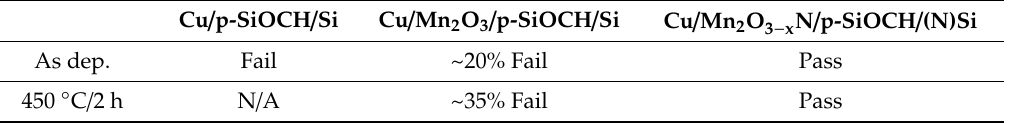
Figure 1. Variation of relative electrical resistivity as a function of annealing temperature for various Cu-gate metal-insulator-silicon (MIS) capacitors. Table 1. Tape test results of various MIS capacitors before and after